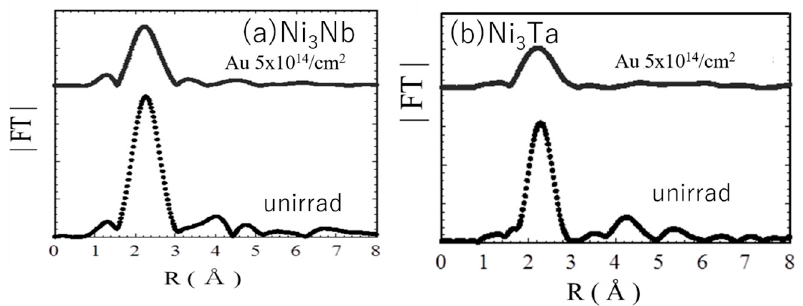
Figure 25. Fourier transformed extended X-ray Absorption Fine Structure (FT-EXAFS) spectra for unirradiated and 16 MeV Au ion-irradiated ( a ) Ni 3 Nb and ( b ) Ni 3 Ta.